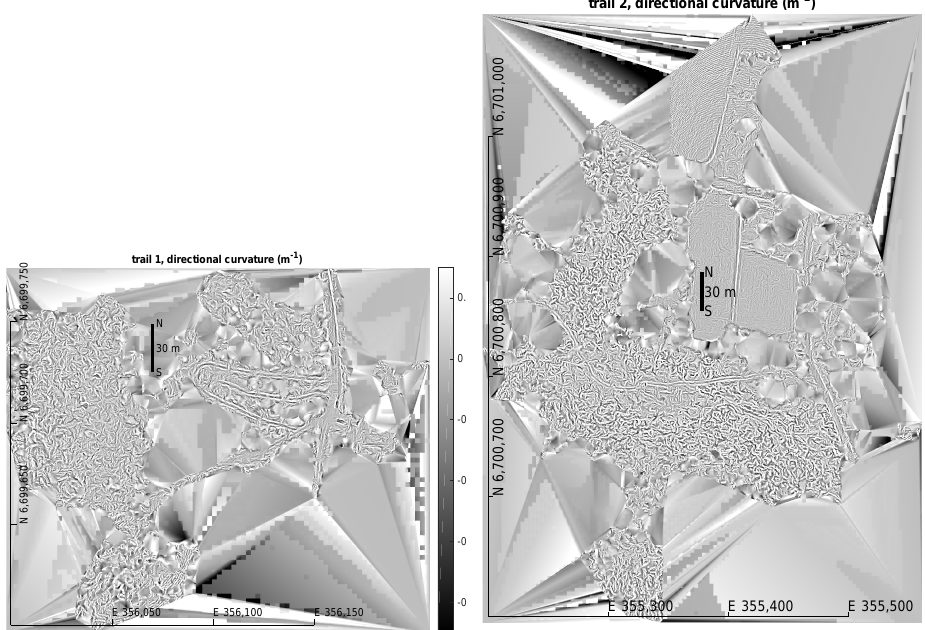
Figure 6. Left : Trail 1; Right: Trail 2. The directional curvature at the locally-dominant direction. The visualization is formed from 20 different directional curvature images by tiling them using 3.8 m image tiles. Left : Trail 1 is in the center. Right : Trail 2 traverses horizontally across the lower part of the image. Co-ordinates are in ETRS-TM35FIN